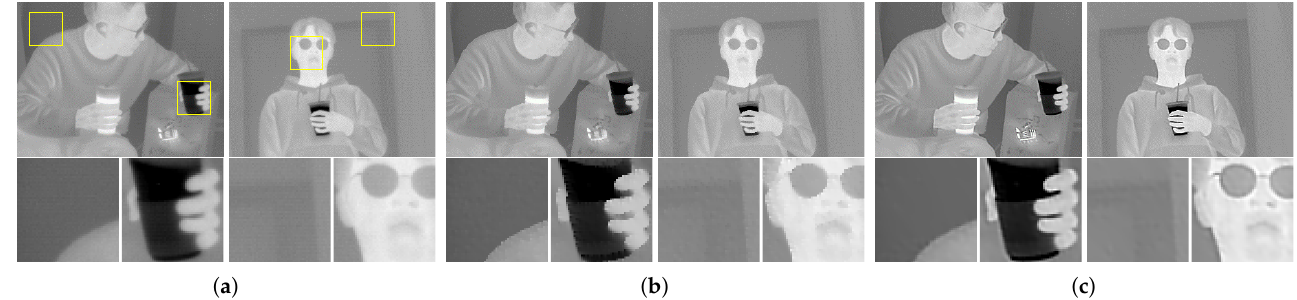
Figure 12. Results of image deconvolution. Regions marked with rectangles are magnified. In the case of image deconvolu- tion, isotropic TV has generated clear output images. ( a ) Degraded original image; ( b ) restored based on the regularization term of Equation (24); ( c ) restored based on the regularization term of Equation